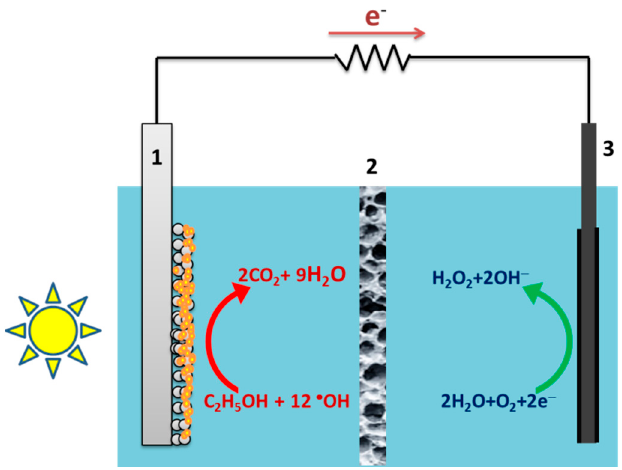
Figure 1. Schematic illustration of the photoelectrocatalytic production of a solar fuel by the consumption of an organic sacrificial agent: ( 1 ) photoanode carrying a mesoporous semiconductor photocatalyst; ( 2 ) ion transfer membrane separating the photoanode from cathode compartment; and ( 3 ) cathode electrode carrying an electrocatalyst. Examples of an oxidation and a reduction reaction in an alkaline environment are also illustrated. Ethanol is oxidized at the photoanode, while hydrogen peroxide is produced by the reduction of oxygen at the cathode.